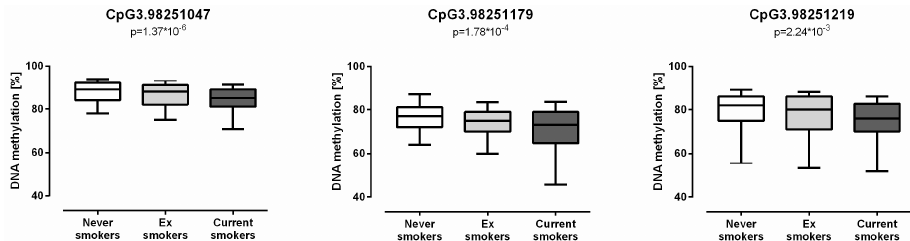
Figure 3. Decreased G protein-coupled receptor 15 ( GPR15 ) DNA methylation in smokers. Methylation of GPR15 DNA negatively correlated with smoking in the three newly identified sites CpG3.98251047, CpG3.98251179, and CpG3.98251219 ( n = 114–582). Linear mixed regression model adjusted for age and sex with a significance threshold of 0.0083 after Bonferroni correction, the box plot whiskers represent 10–90th percentile.